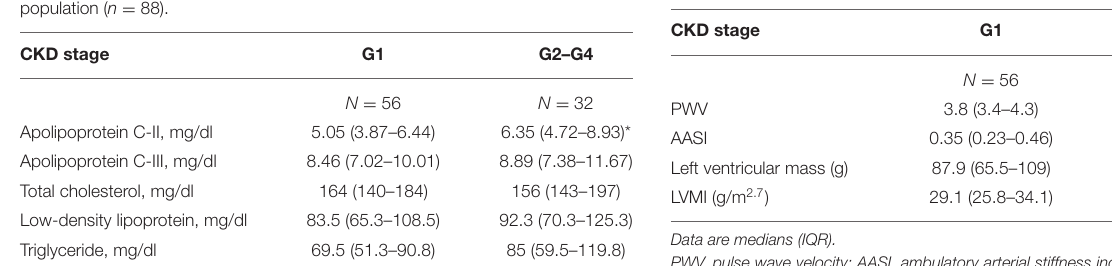
TABLE 4 | Cardiovascular assessments of study population ( n =